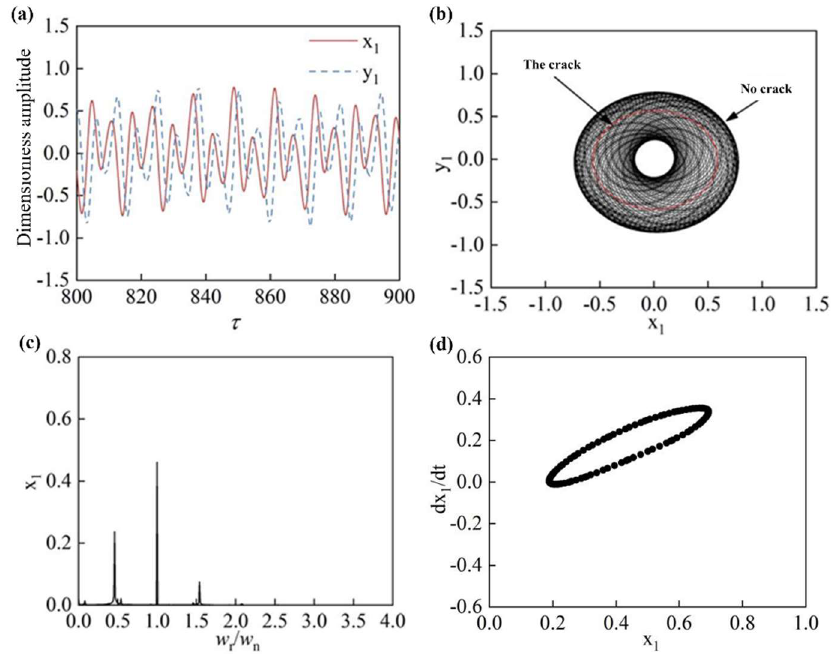
Figure 11. Rotor dynamics response under rub-crack: ( a ) time domain curve of impeller displacement change; ( b ) impeller axis locus; ( c ) frequency spectrum of impeller; ( d ) impeller poincare drawing.